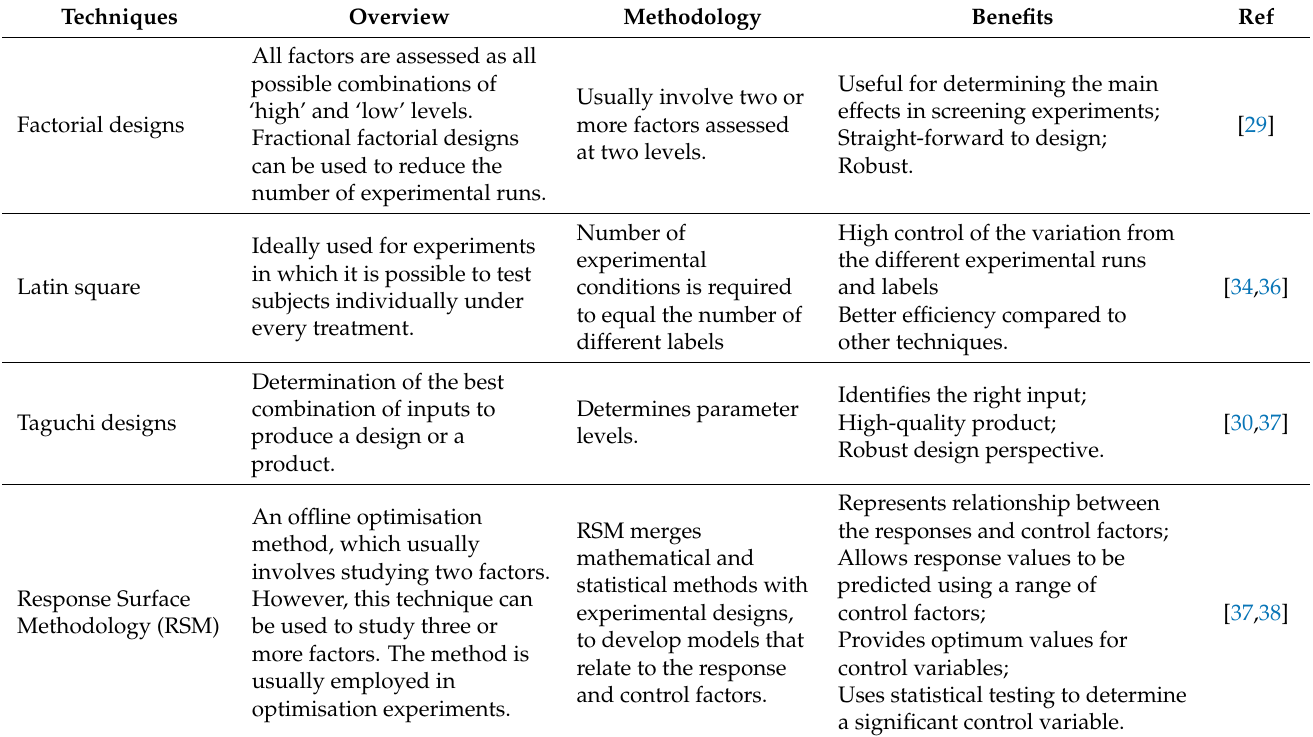
Table 1. Overview of the Design of Experiments (DoE)